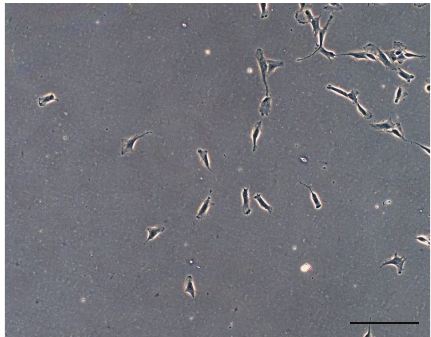
Figure 3: Primary cultures of small round cell osteosarcoma. Observation in phase contrast of primary cells of small round cell osteosarcoma obtained after 24h from the mechanical disgregation of the biopsy sample. Original magnification 10x. Bar size: 100 𝜇